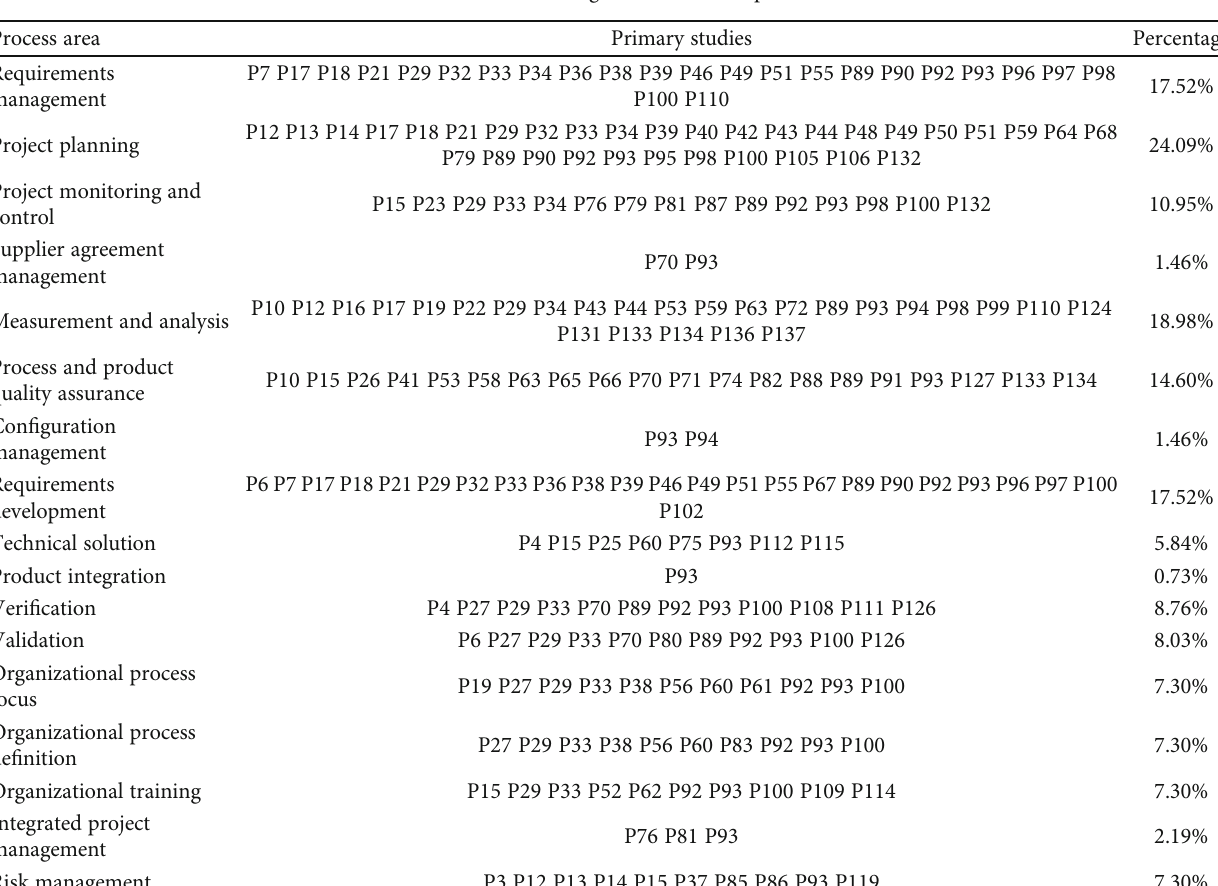
Table 16: Studies with gami fi ed software